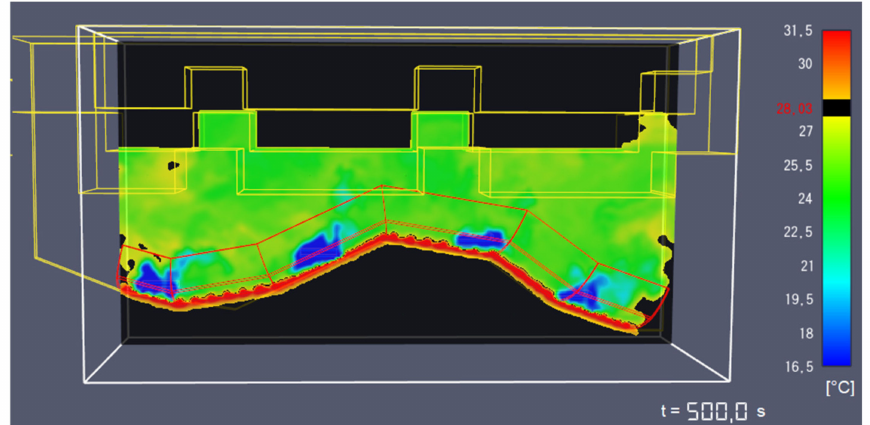
Figure 14. Reference configuration: air temperature distribution in the horizontal section z = 1.1 m at t = 500